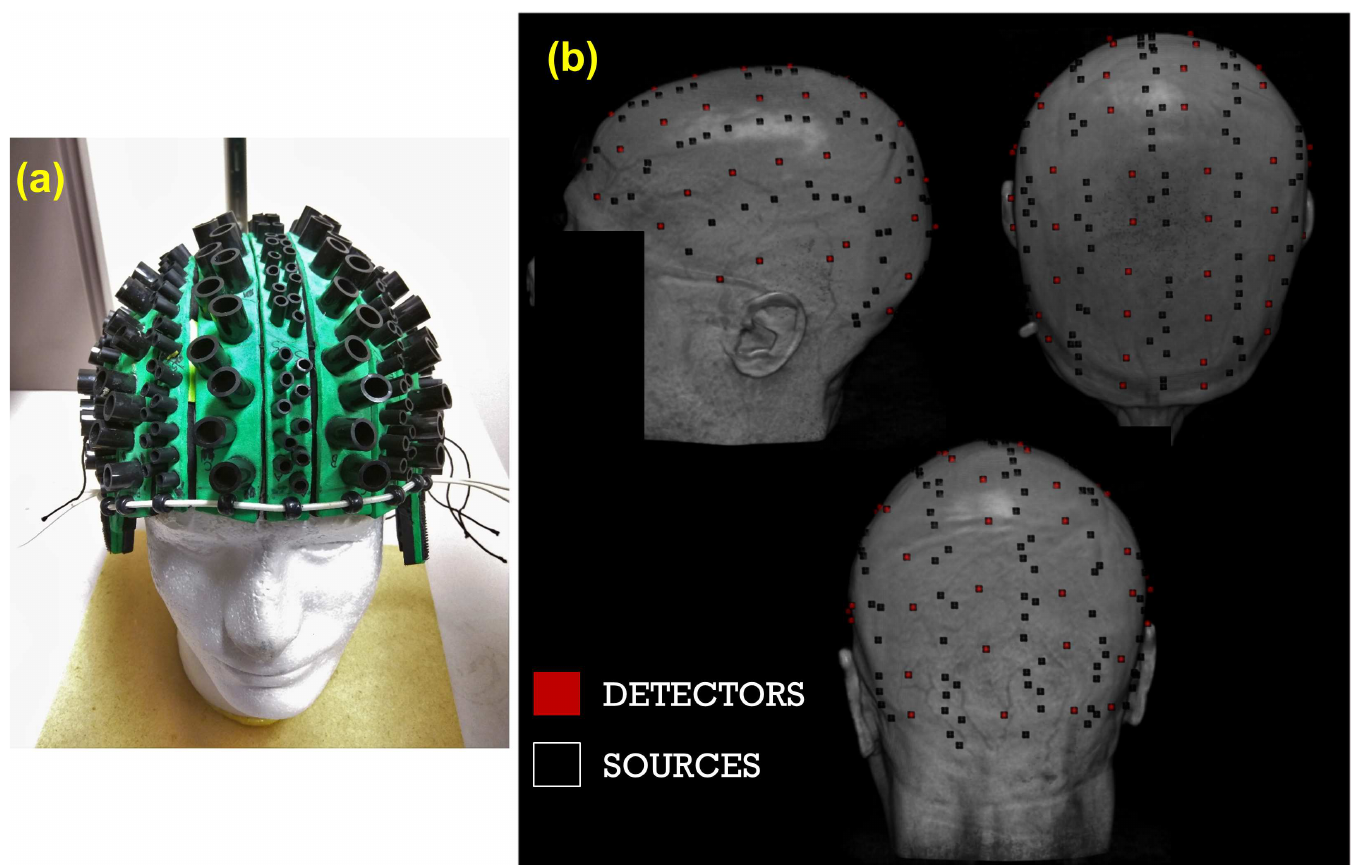
Fig 1. (a) Photographof the soft foam, adjustable optical recordingcap used in the study. Detectors were fitted into the larger tubes whilesources were fitted into the smaller tubes. The cap was further securedto the subject’s head by tighteningan elastic band aroundits circumference of the cap and through the usage of a custom-built chin strap. (b) Locationsof sources (black) and detectors (red) digitizedin one representativeparticipant, and plotted over the correspondingsurface-renderedstructural MRI (left, top and back